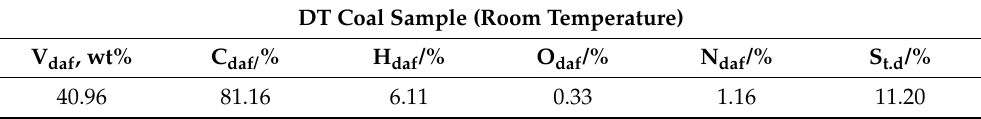
Table 1. Volatile and elemental analysis of coal